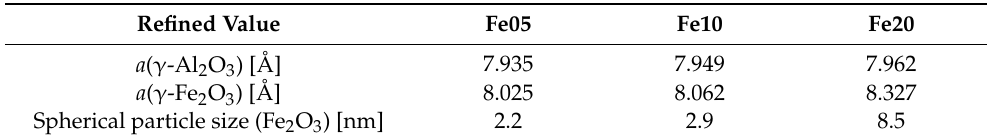
Figure 3. ( a ) PDF refinement of laboratory PDF data of Fe20 with experimental data (G obs ) fitted curve (G calc ) and difference between G obs and G calc (G diff ). γ -Al 2 O 3 (grey) and γ -Fe 2 O 3 (orange) crystal structures were used; ( b ) magnification of the range of 1–10 Å showing some structural features left in the difference curve; R w = 0.31; G(r) = reduced pair distribution function. Table 2. Refined values for the lattice parameter of γ -Al 2 O 3 and Fe 2 O 3 and the spherical particle size of Fe 2 O 3 for Fe05, Fe10, and